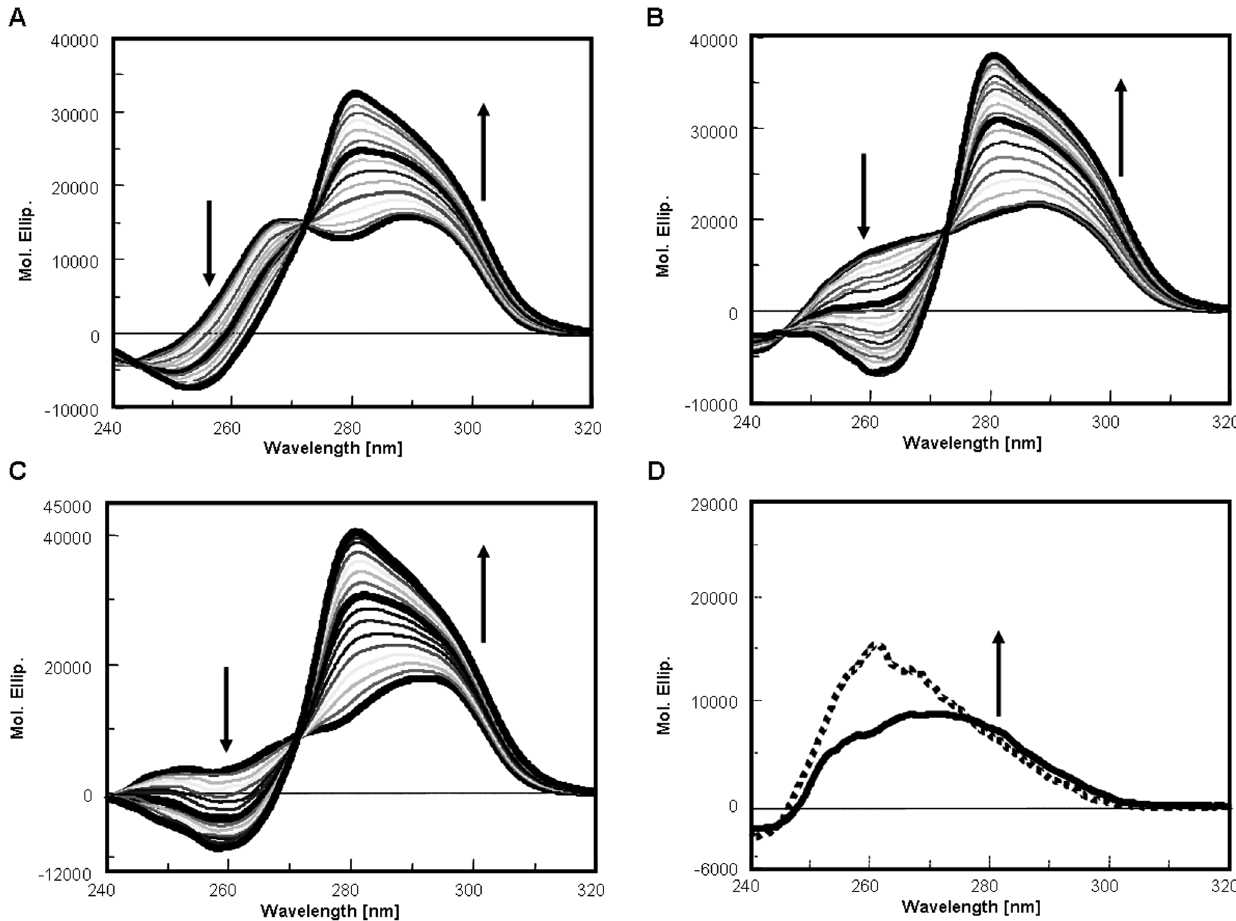
Figure 4. (K34) 2 Ni(II)-G-quadruplex bound form shows conserved CD spectra features. Dichroic spectra of 4 m M Tel26 (Panel A), wtTel26 (Panel B), Tel22 (Panel C) or single strand scrambled scT22 (Panel D) in the presence of increasing concentrations of (K34) 2 Ni(II) at 25 u C in 10 mM Tris, 20 mM KCl, at pH 7.5. Arrows indicate changes upon addition of the metal complex, curves in bold indicate spectra of the free oligonucleotide and at 1:1 and 2:1 ligand:DNA ratios in panels A–C. In panel D the solid line corresponds to the CD contribution of DNA alone, the dotted line represents the dichroic spectrum at saturating concentrations of (K34) 2 Ni(II).